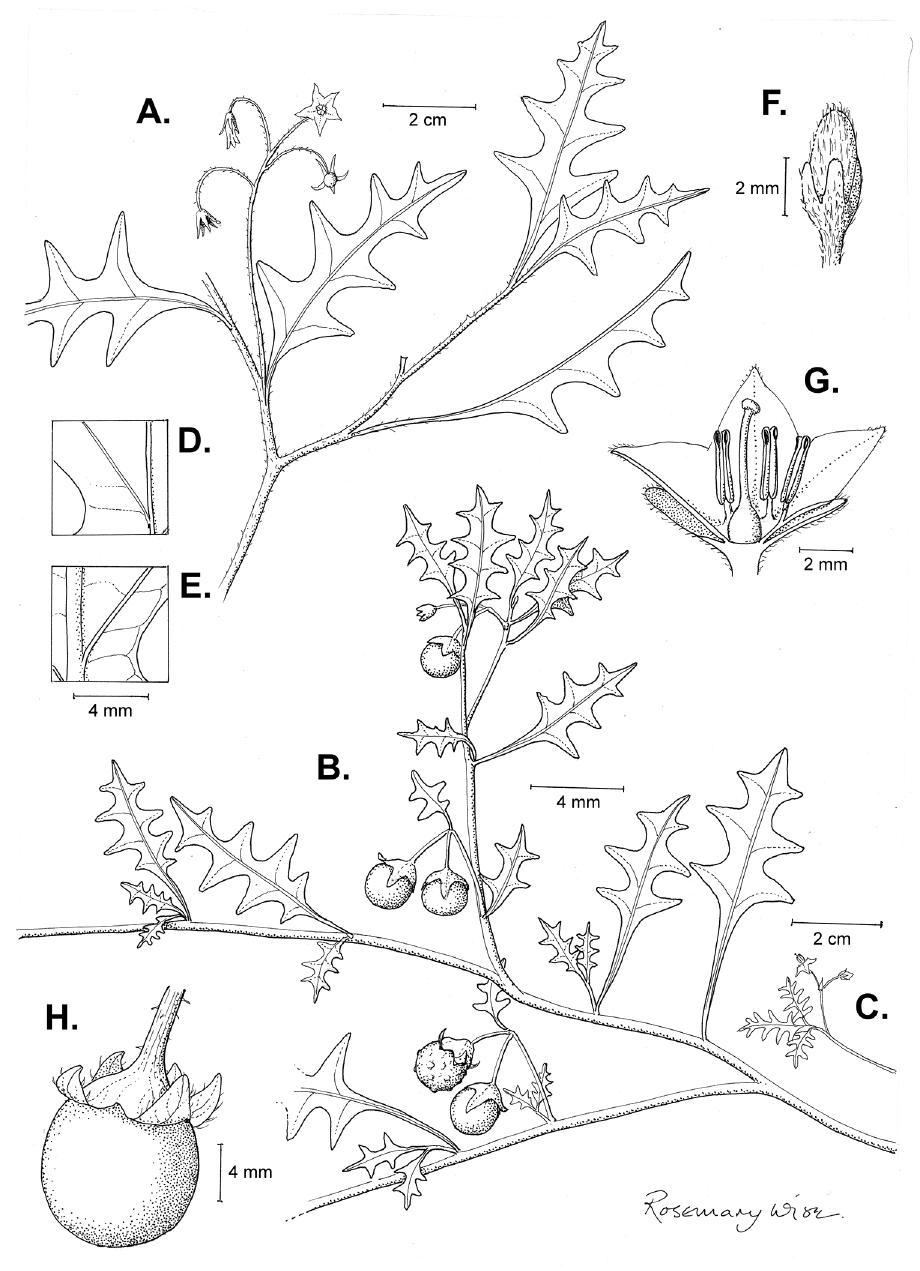
Figure 51. Solanum triflorum Nutt. A Flowering habit B fruiting habit C flowering branch D detail of adaxial leaf surface E detail of adaxial leaf surface F bud G dissected flower H fruit ( A, C, F ,G Donat 55 ; B, D, E, H Baker 577 ). Drawing by R. Wise (previously published in “PhytoKeys